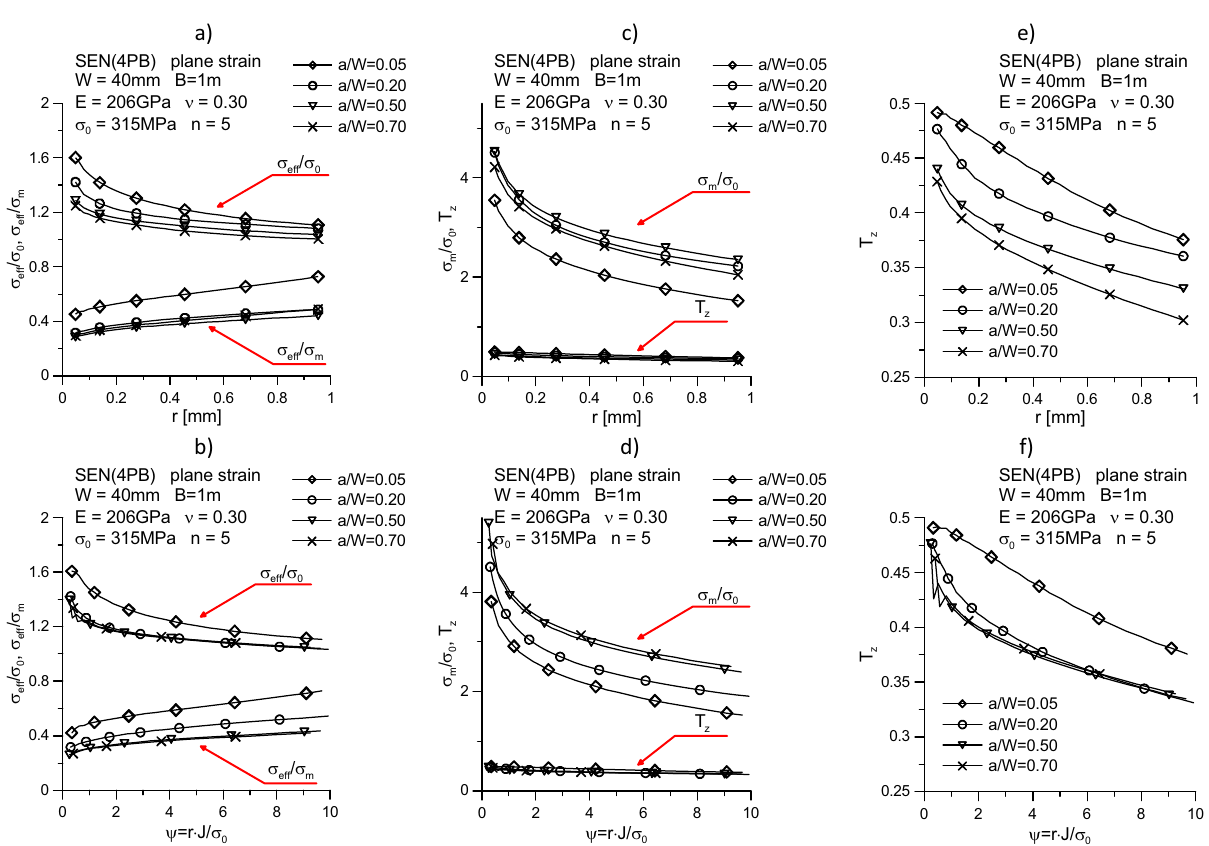
Figure 18: In fl uence of the relative crack length a / W on the distribution of selected parameters: σ e ff / σ 0 and σ e ff / σ m ( a and b ) ; σ m / σ 0 and T z ( c and d ) ; T z parameter ( e and f ) , near the crack tip ( graphs ( a, c, and e ) were prepared for the physical distance from the crack tip; graphs ( b, d, and f ) were prepared for the normalized distance from the crack tip ψ = r · J / σ 0 ; the charts are presented for the moment when the external load reaches the limit load value – P / P 0 = 1.00; with the following values of the J integral for subsequent specimens: a / W = 0.05, J = 31.0 kN/m; a / W = 0.20, J = 49.3 kN/m; a / W = 0.50, J = 29.3 kN/m; a/ W = 0.70, J = 18.4 kN/m )